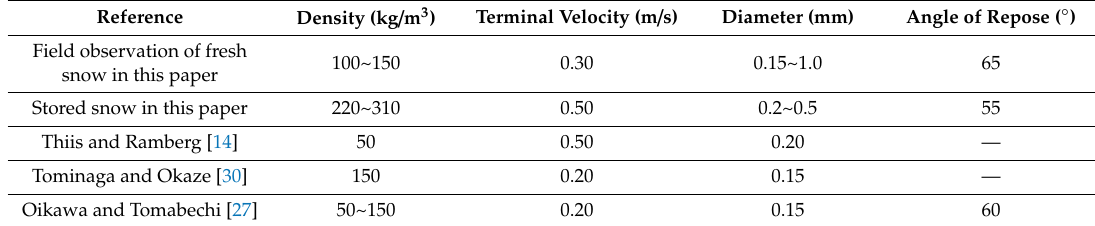
Table 1. Comparison of the physical parameters of the snow particles.